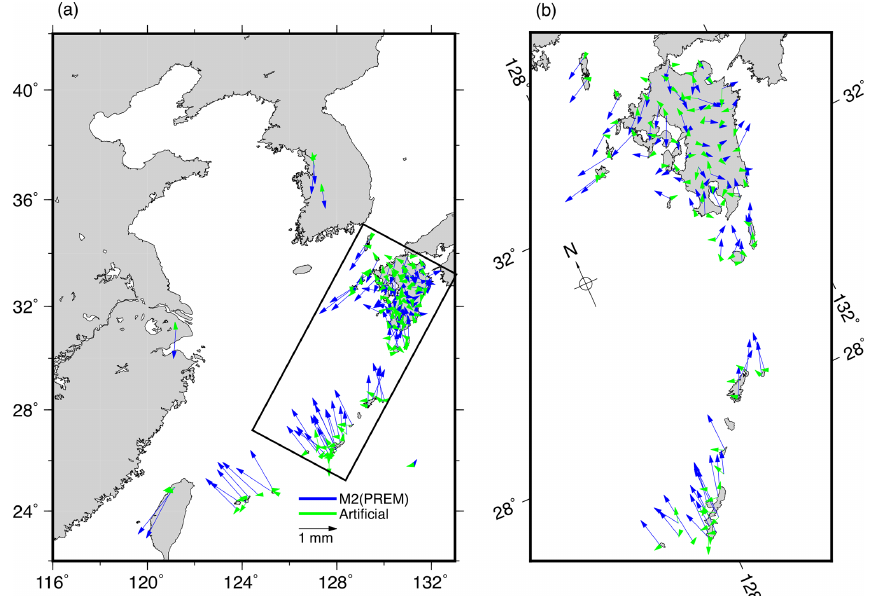
Figure 4. Phasor differences (in blue) between the GPS-observed M 2 vertical OTL displacements and the predictions computed using the NAO99Jb regional ocean tide model (augmented elsewhere globally with FES2014b) and an elastic PREM Green’s function. Also shown (in green) are the phasor differences between the recovered and original artificial ∼ 13 . 96h harmonic vertical displacement signal of 3.0mm amplitude. (a) Shows the whole ECS region, while (b) is an enlargement of Kyushu and part of the Ryukyu Islands, from the boxed region in (a)